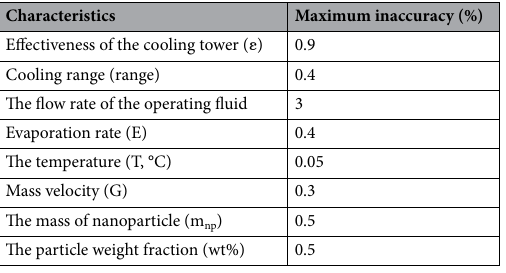
Table 4. The maximum inaccuracy in the obtained